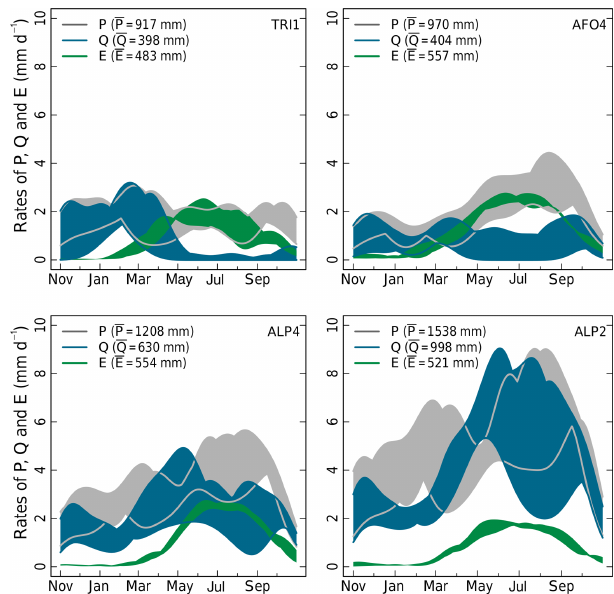
Figure 3. Regime curves of observed areal precipitation (P) (grey), discharge (Q) (blue), and calculated areal mean evapotranspiration ( E , Penman–Monteith) (green) of four selected headwater catch- ments. The width of the individual bands illustrates the inter-annual variation during the 4-year long period. The curves are based on kernel density estimates using identical kernels and bandwidths for variables of the same type. P , Q , and E provide the 4-year mean annual average of the different variables,